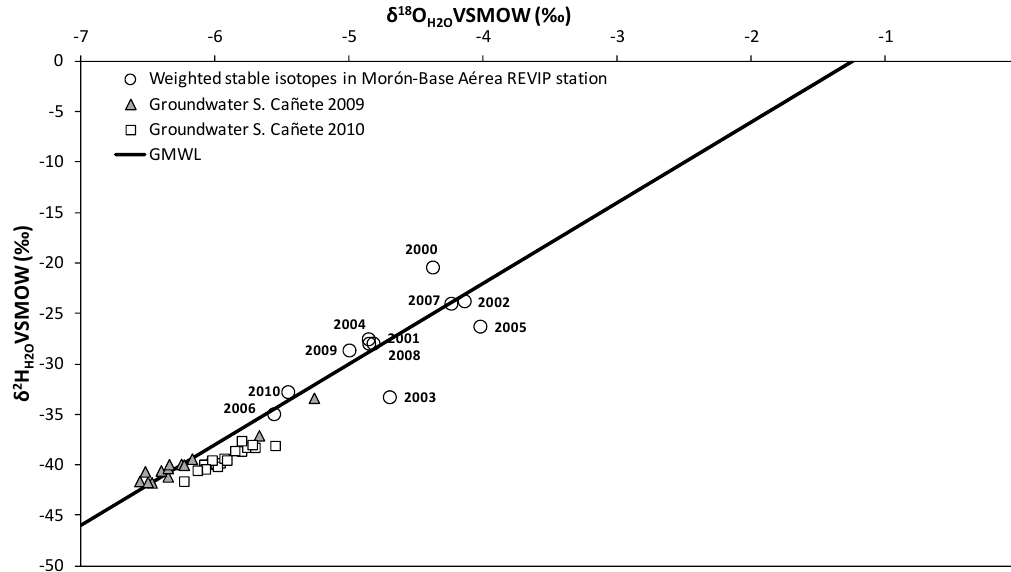
Figure 5. Comparison between weighted stable water isotope in the precipitation of the Morón-Base Aérea REVIP station and the groundwater samples of the Sierra de Cañete aquifer.